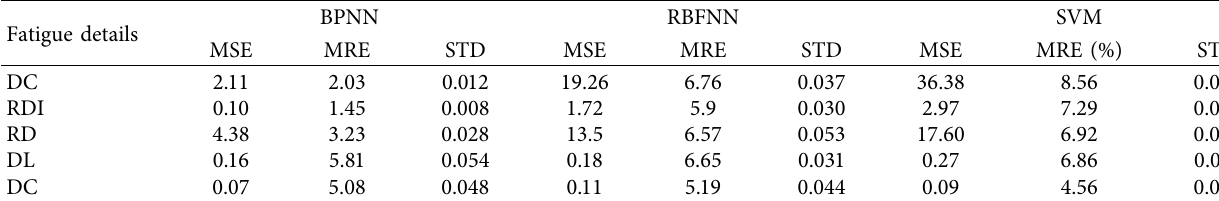
Figure 15: The outcomes of BPNN, RBFNN, and SVM. (a) DC. (b) RDI. (c) RD. (d) DL. (e) RC. Table 4: Prediction performance of BPNN, RBFNN, and